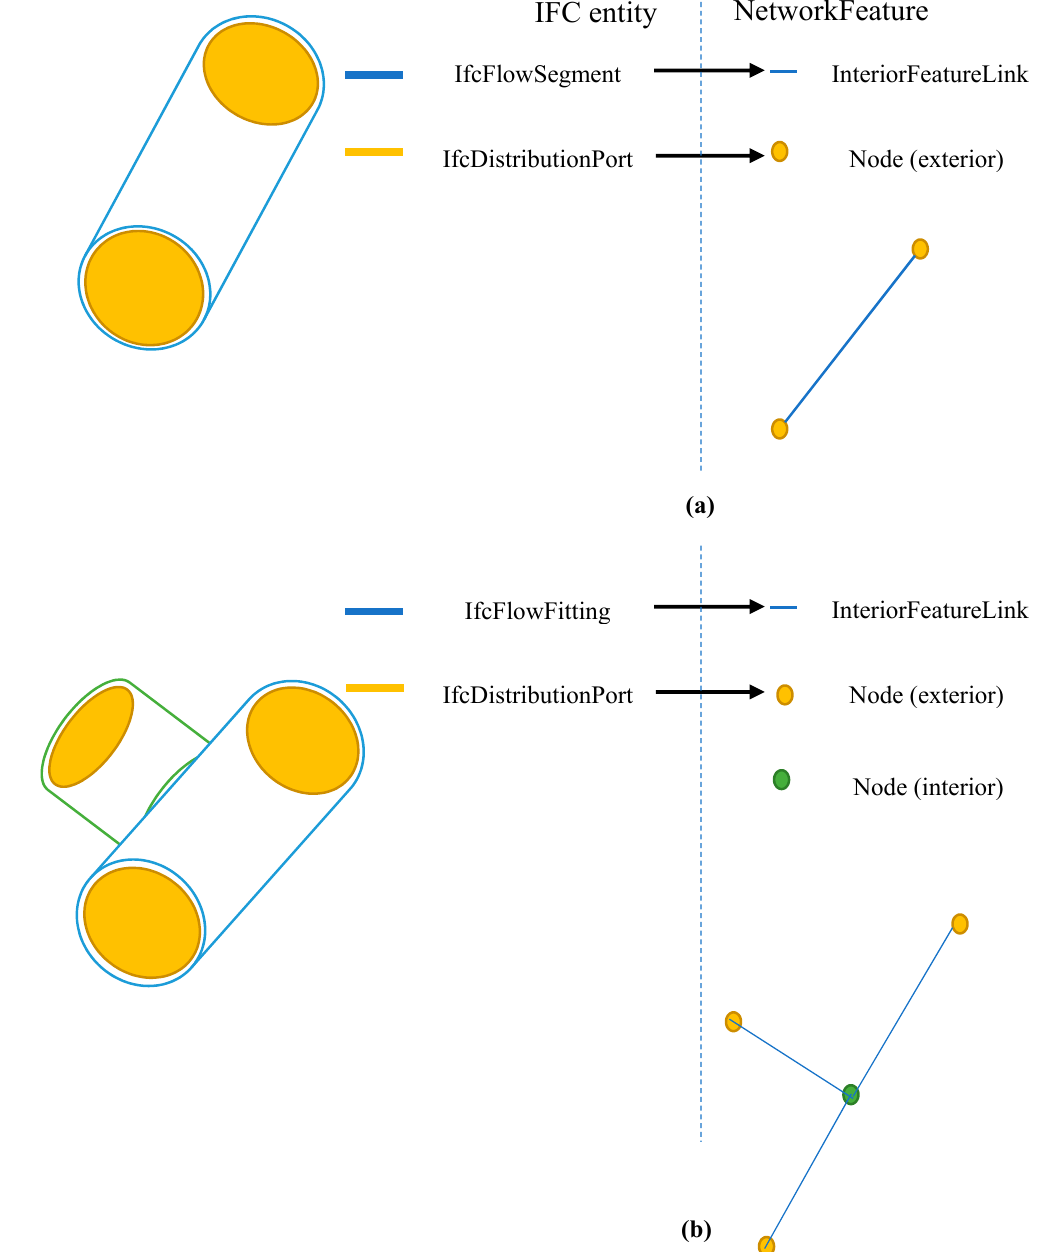
Figure 3. ( a ) IfcFlowSegment connected to two distribution ports represented by Featuregraph class in CityGML; ( b ) IfcFlowFitting connected to three ports using Featuregraph class in CityGML.